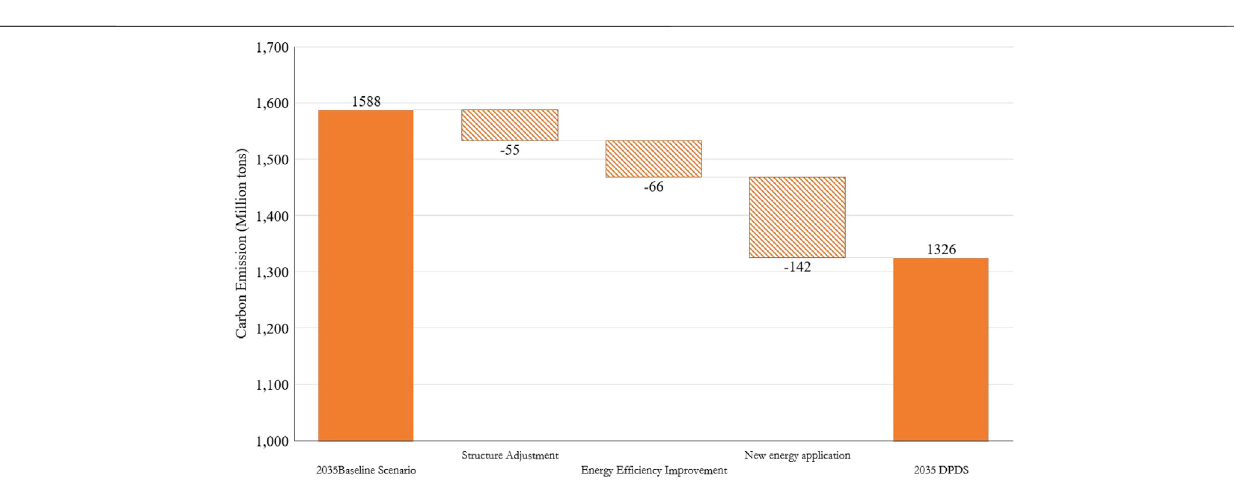
Frontiers in Environmental Science |